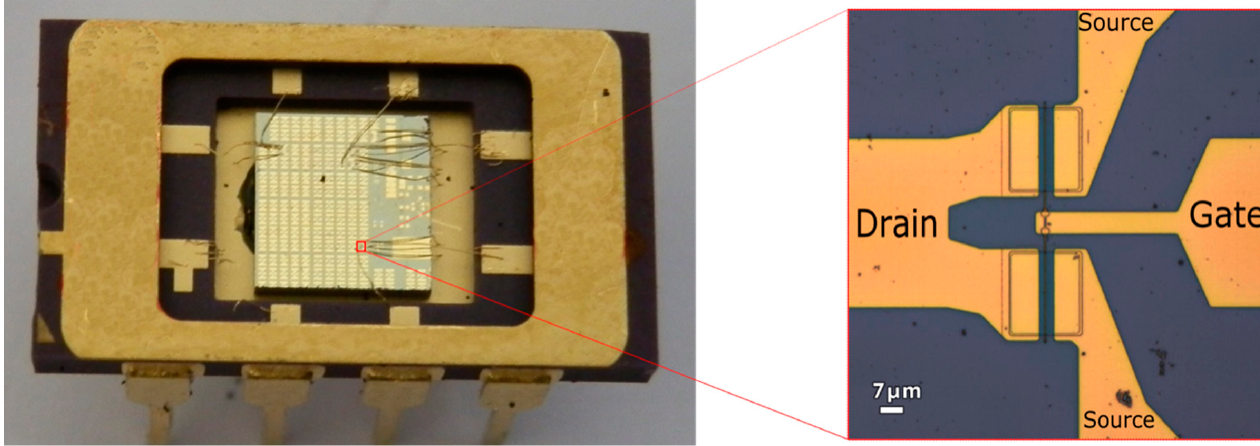
Figure 3. Left : The chip containing the strained-Si MODFETs used in this work mounted on a dual in line package (DIP8) and gold wire-bounded to it. Right : Magnified view of a transistor showing the T-gate.